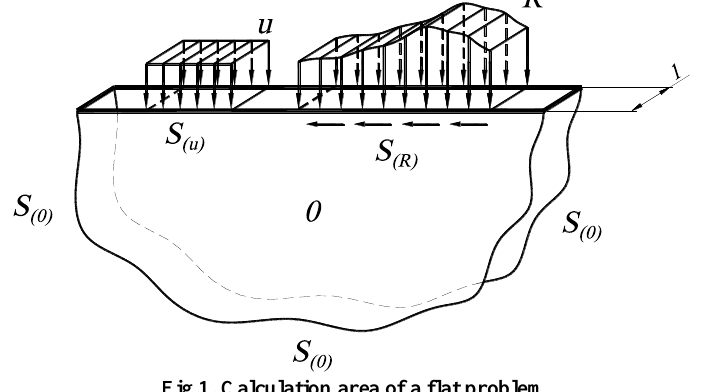
Fig.1. Calculation area of a flat